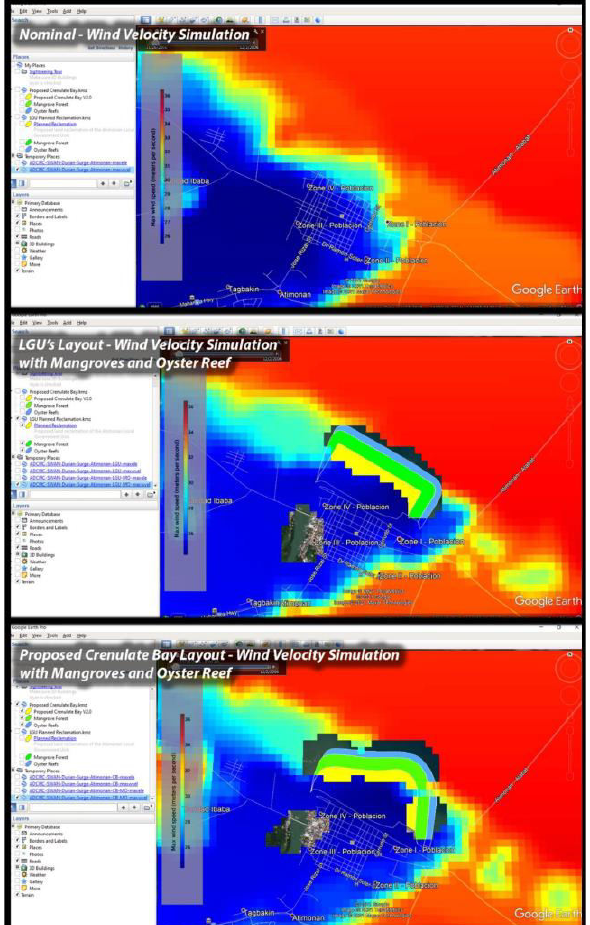
Figure 12 . Simulated maximum wind speed induced by Typhoon Durian simulated on Atimonan. From top to bottom: nominal (no reclamation), LGU plan, crenulate bay plan.